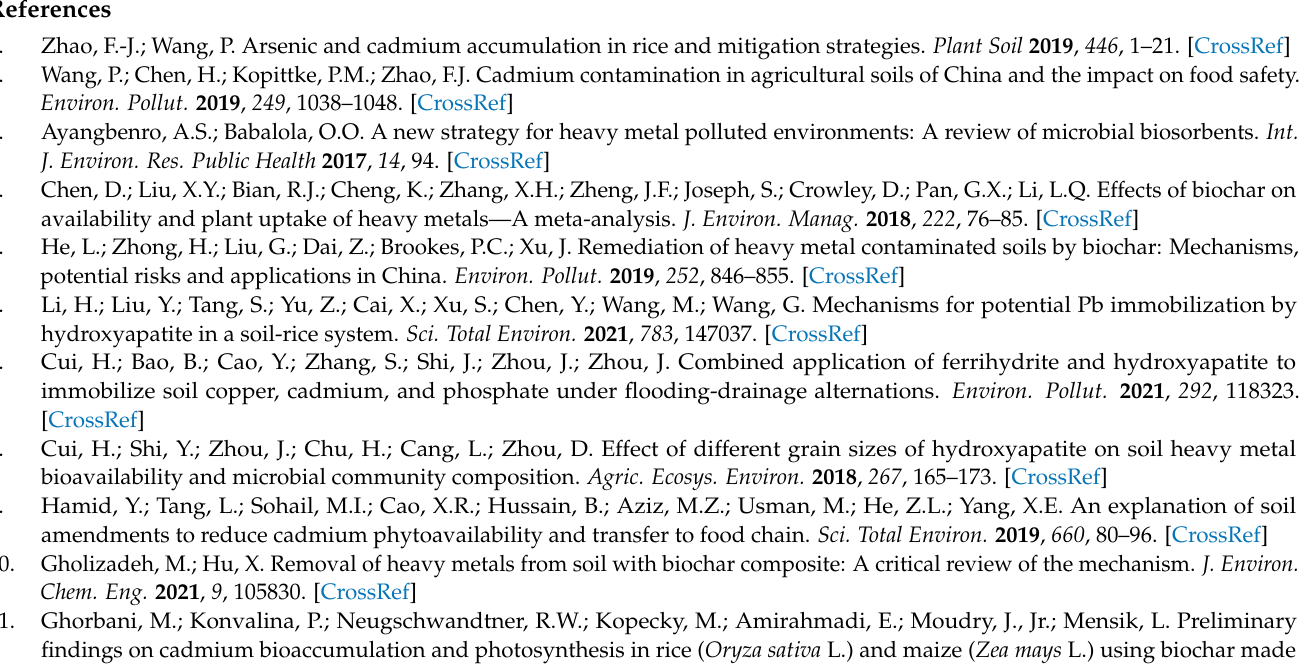
Figure S7: Manhattan plot of metagenomeSeq analysis; Figure S8: LDA scores for soil bacterial communities; Figure S9: LEfSe taxonomic cladogram; Figure S10: LDA scores for soil bacterial communities. Table S1: Significance levels ( F value) of sweet sorghum density, remediation agent type, and their interactions for measured variables according to a two-way ANOVA analysis; Table S2: Effects of different treatments on soil properties and Cd content in plants; Table S3: Pearson test for edaphic factors and cadmium content in plants; Table S4: Pearson test for edaphic factors and alpha diversity index; Table S5: Statistical table of sample sequencing amount; Table S6: Alpha diversity index; Table S7: The relative abundance (%) of the top 10 phyla as affected by different treatments; Table S8: The relative abundance (%) of the top 10 orders as affected by different treatments. Table S9: The relative abundance (%) of the top 15 genus as affected by different